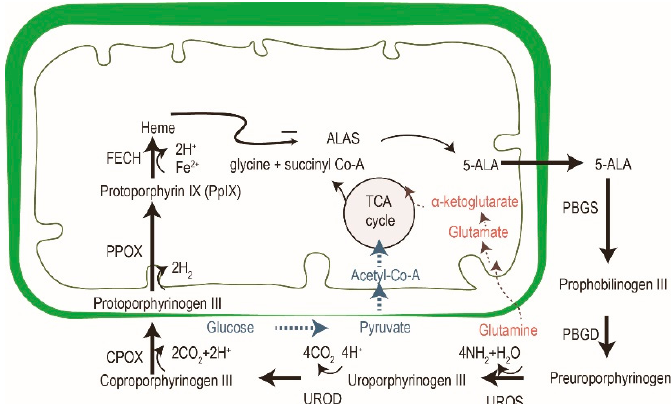
Figure 4. The cross-talk of glucose, glutamine and porphyrin heme biosynthesis pathways. In addition to porphyrin synthesis via the tricarboxylic cycle acid (TCA) cycle, the accumulation of PpIX in tumor cells might be explained by an increase of glycolysis (in blue) and glutaminolysis (in red). Modified from reference 24.